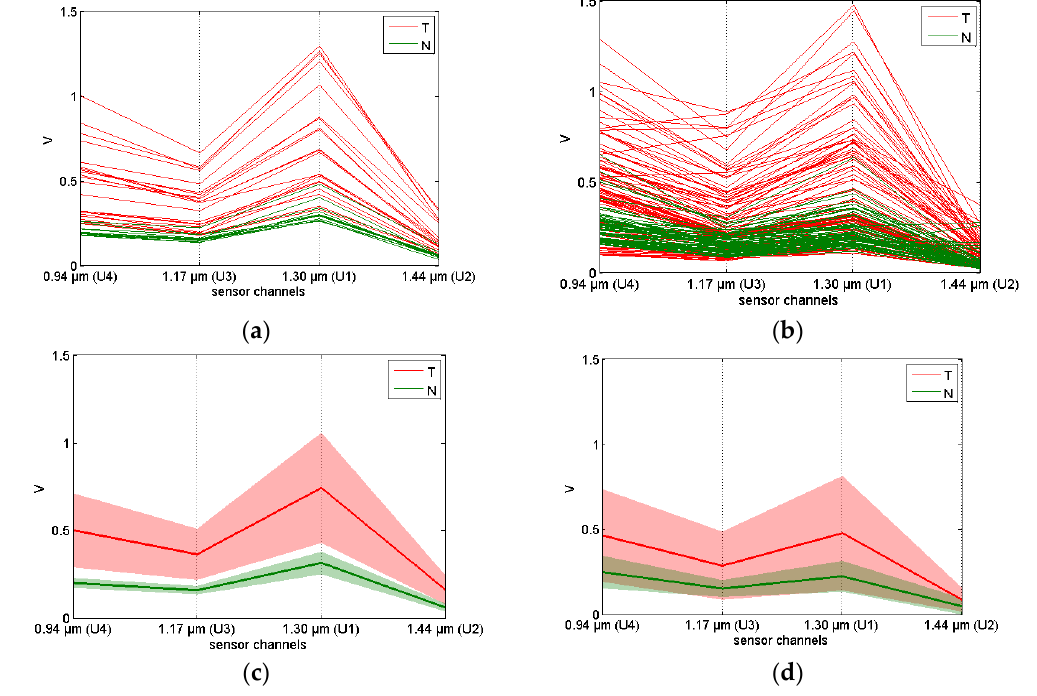
Figure 8. Sensor data: ( a ) Series A, ( b ) Series B, and ( c , d ) the data mean and standard deviation in Series A and B, respectively. Tumor and normal tissue measurements are shown with red and green lines, respectively. (Reproduced with permission from authors [29]).